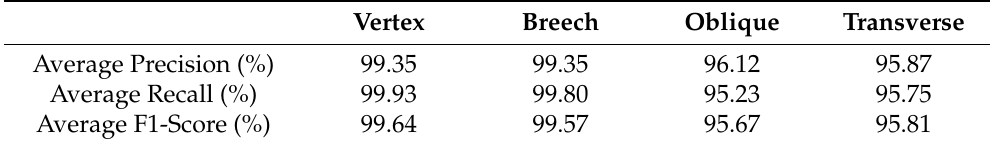
Table 1. Summary of performance metrics for Fet-Net during the 5-fold cross-validation experiment. Vertex Breech